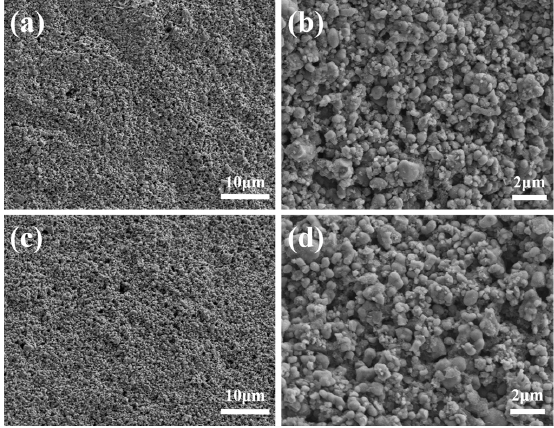
Figure 8. SEM images of the surface of printed LFP electrodes: ( a , b ) room temperature printed LFP electrodes; ( c , d ) LTDW printed LFP electrodes.